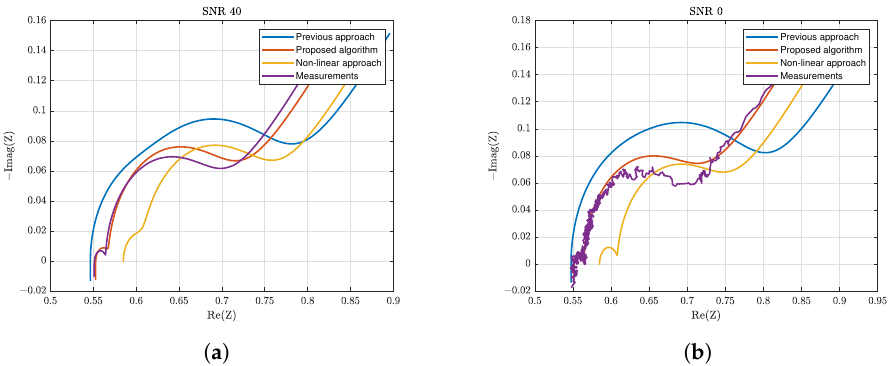
Figure 11. Performance comparison.(Estimated parameters are used to reconstruct Nyquist plot).